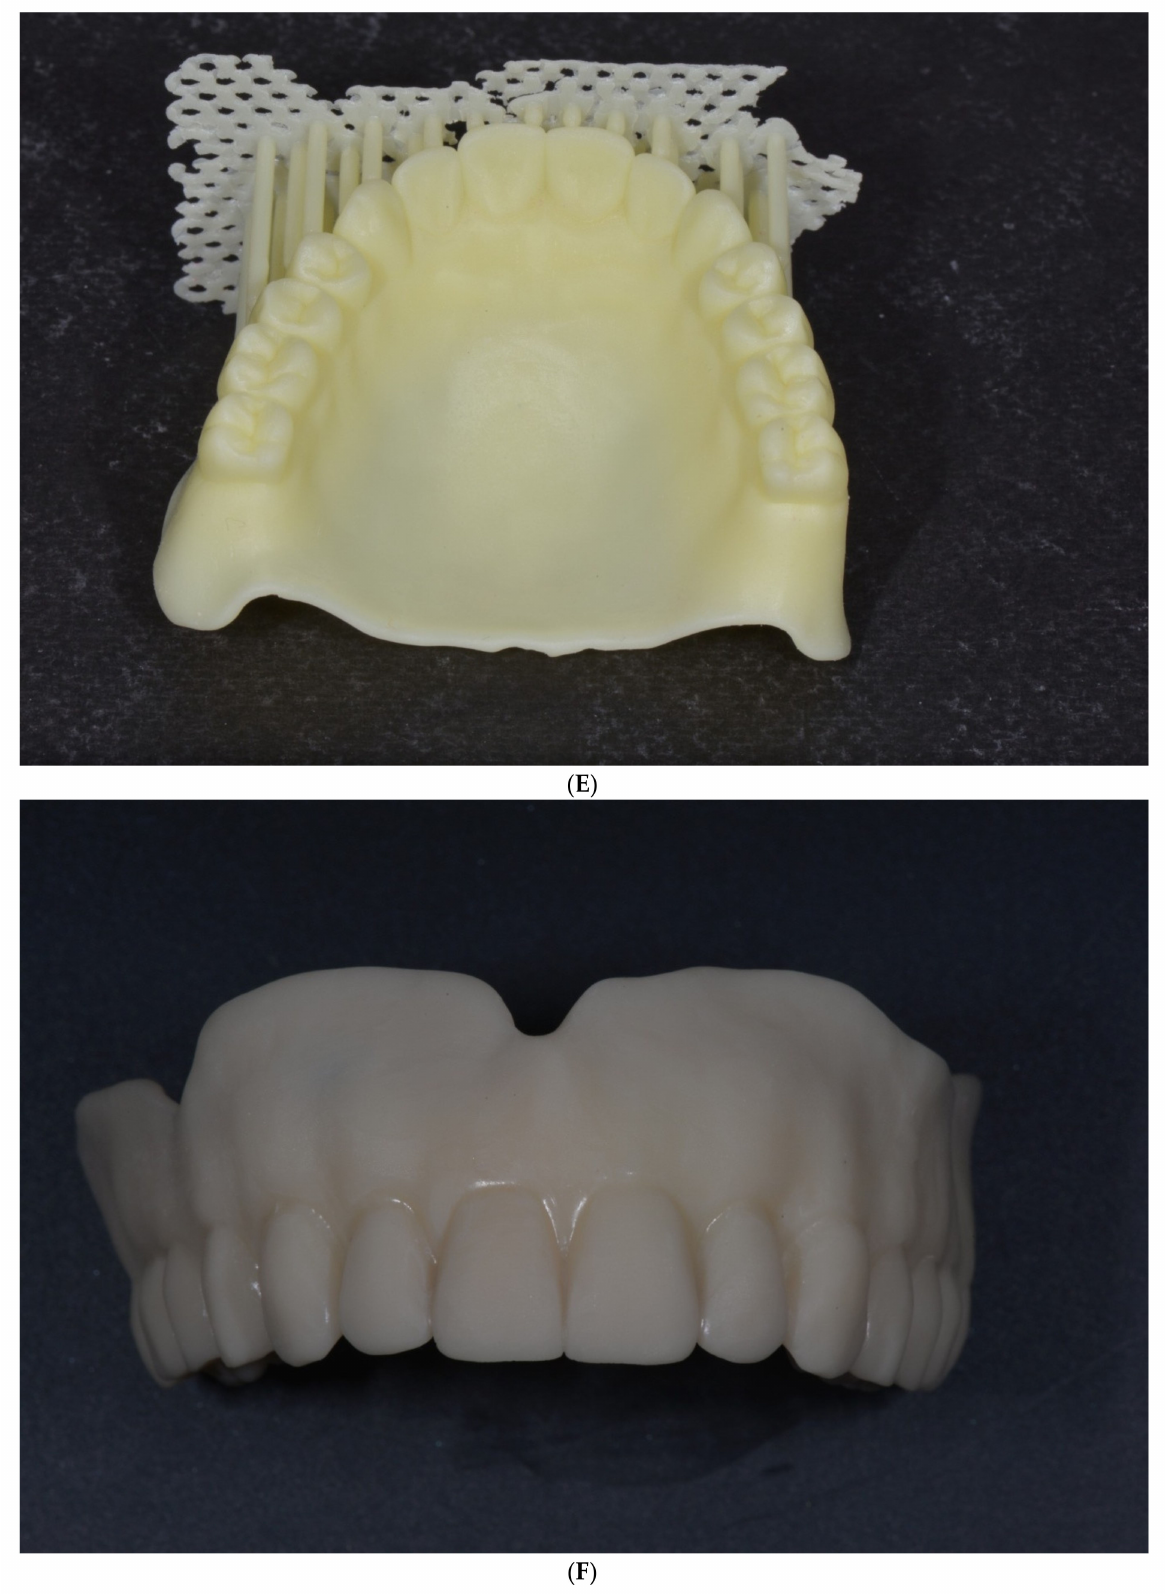
Figure 1. Trial denture fabrication. ( A ): Anatomic structures are identified on the edentulous ridge image. ( B ): Limit of the future denture base is drawn. ( C ): Denture teeth are arranged. ( D ): Denture base is designed. ( E ): Printed trial denture. ( F ): Trial denture is printed as a monolithic denture, teeth, and base in one